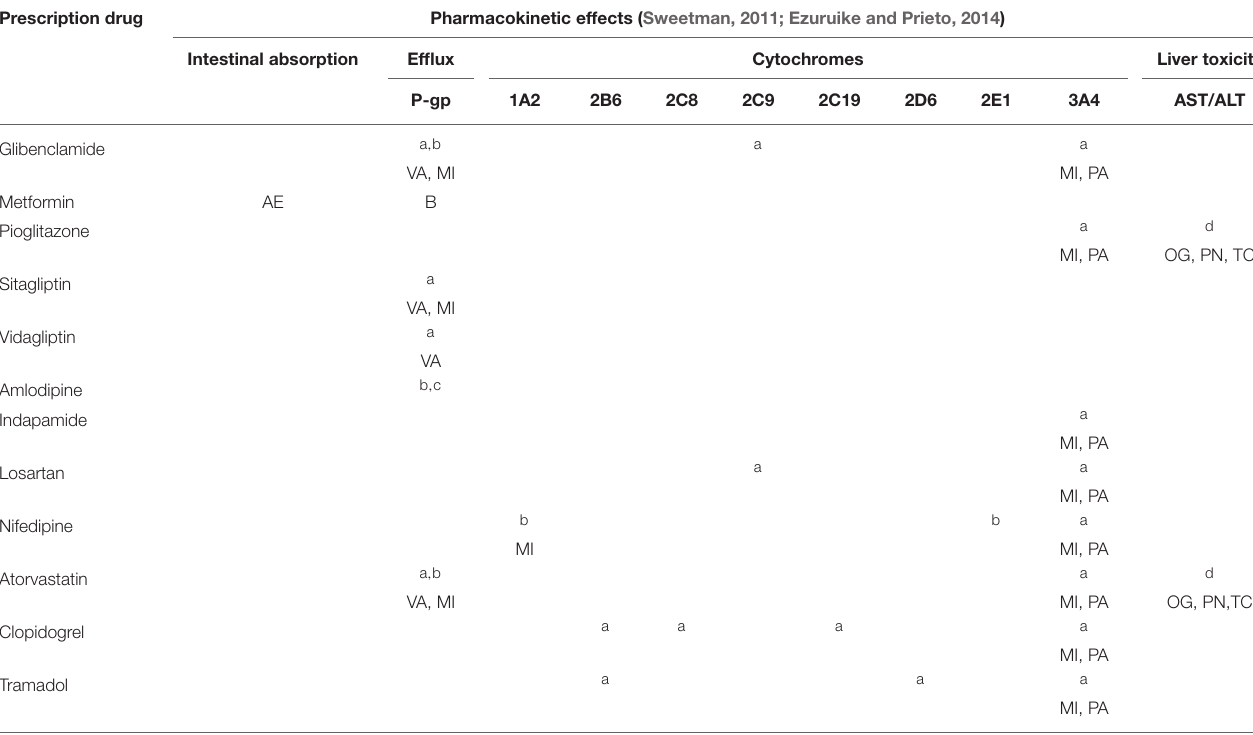
TABLE 4 | Map of the potential pharmacokinetic interaction between the prescribed drugs and the herbal medicines used by the patients. Prescription drug Pharmacokinetic effects (Sweetman, 2011; Ezuruike and Prieto, 2014) Intestinal